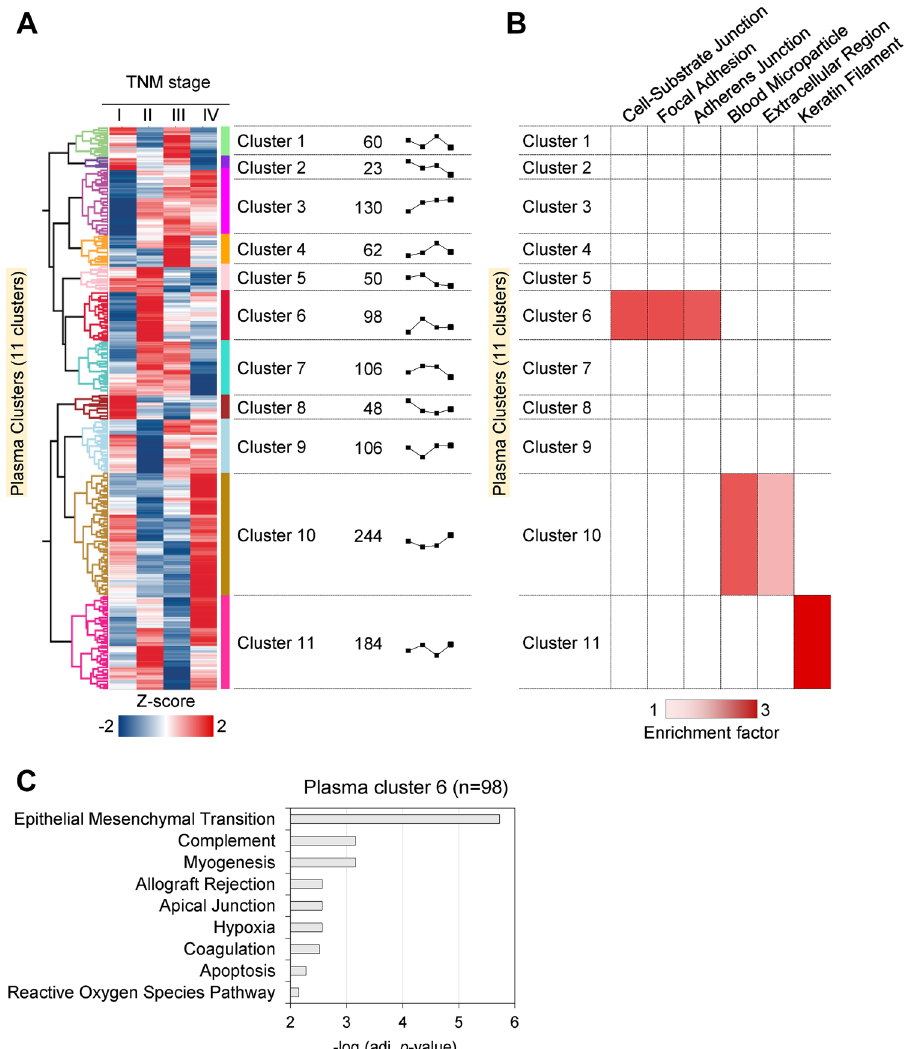
Figure 1. Plasma proteome analysis of CRC according to cancer stage. ( A ) Unsupervised hierarchical clustering analysis of CRC plasma proteins according to CRC stage was performed with Perseus software. Each of the 4 points in the graphic trend represents the averaged z-score of the protein expression level at the same CRC stage. ( B ) Fisher’s exact test between the 11 plasma clusters and GOCC value (Benjamini–Hochberg FDR < 0.02). Color intensity represents the enrichment factor for the association between the plasma cluster and GOCC value. ( C ) Functional enrichment of the plasma cluster 6 to hallmark gene sets from MSigDB (adjusted p -value <